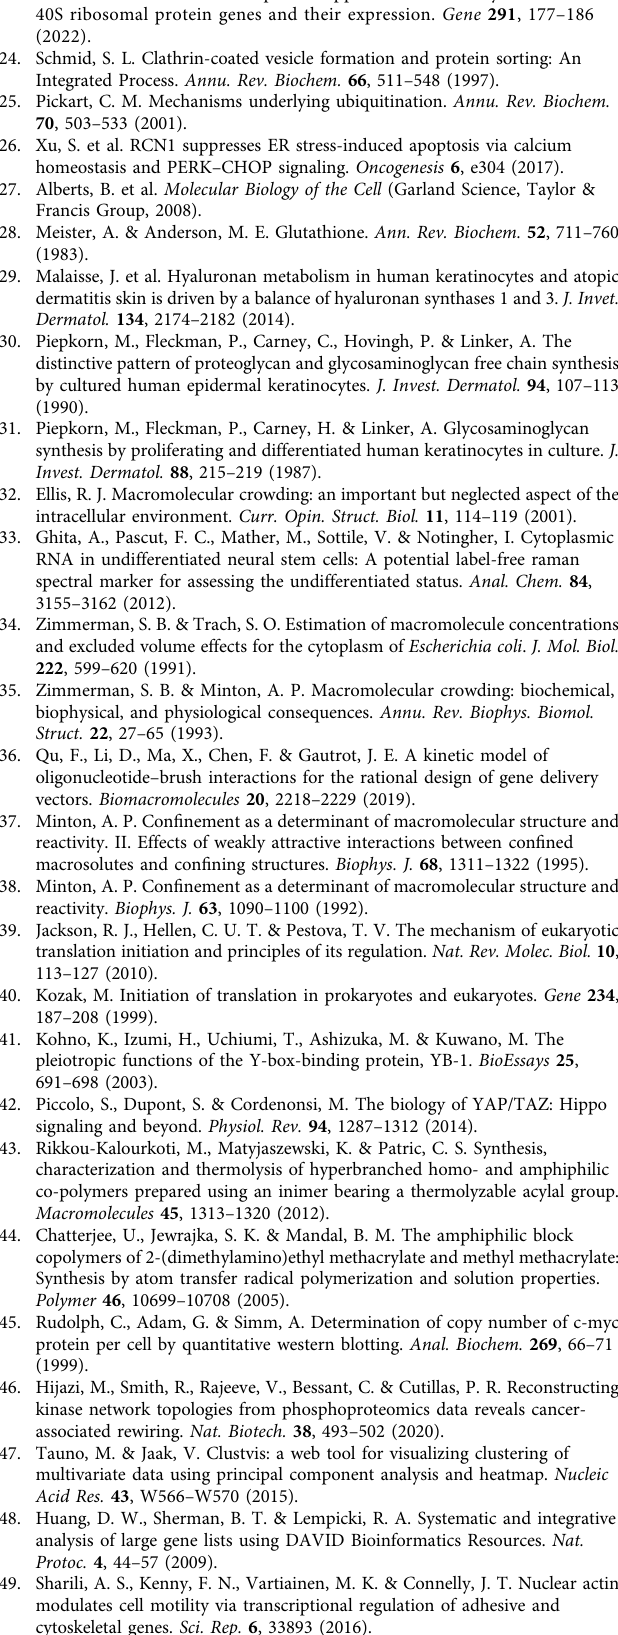
data and statistical analysis summary tables are available in the Supplementary Information. Source datasets for all fi gures are available from the corresponding author and have been deposited in the QMUL repository. Proteomics data generated in this study have been deposited to the ProteomeXchange Consortium via the PRIDE partner repository with the dataset identi fi er PXD028512 and 10.6019/PXD028512. Source data are provided with this